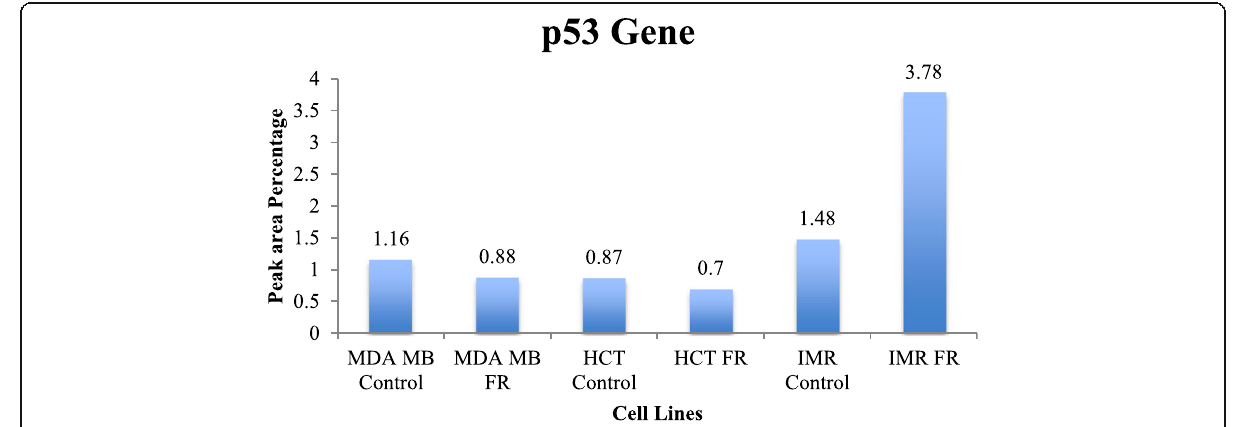
Fig. 11 The relative gene expression of p53 gene in all the cell lines. FR — Ficus religiosa